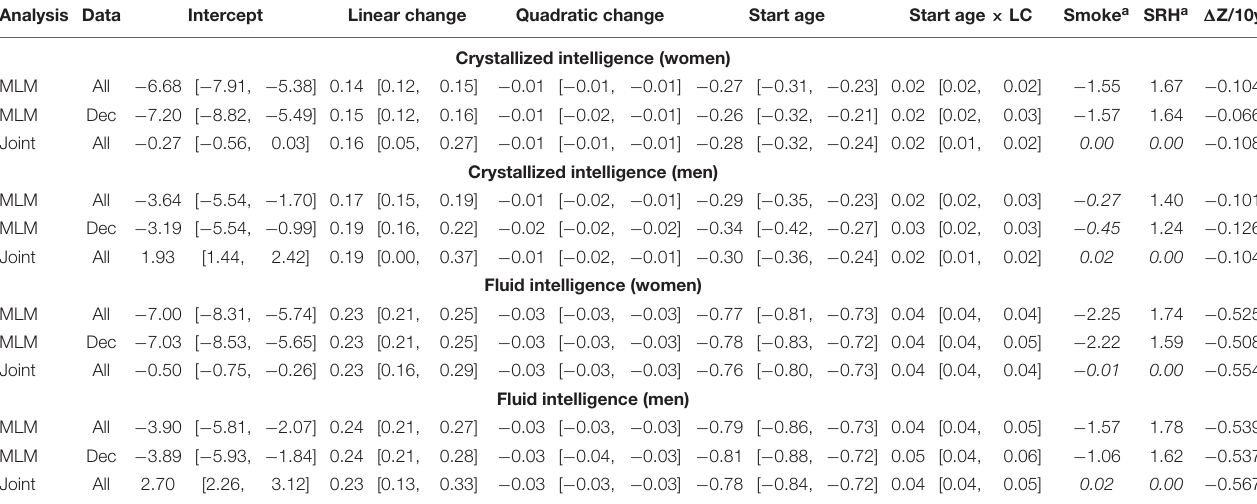
TABLE 5 | Fixed effects from quadratic change models (adjusted for starting age, self-rated health, and smoking). Analysis